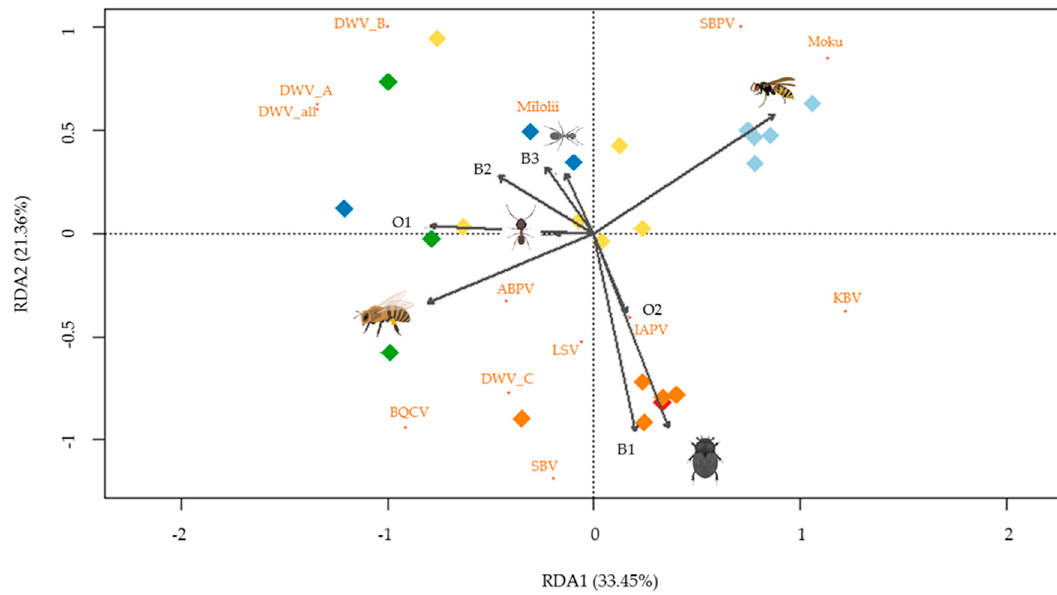
Figure 6. Redundancy Analysis (RDA) plot showing the variation in virus read count data (RPKM log-10) for each sample correlated with environmental variables: site and species. Dummy variables were randomly assigned to varroa (species) and B4 (site). Sites are colored: O1 = green, O2 = red, B1 = orange, B2 = dark blue, B3 = yellow, and B4 = light blue.